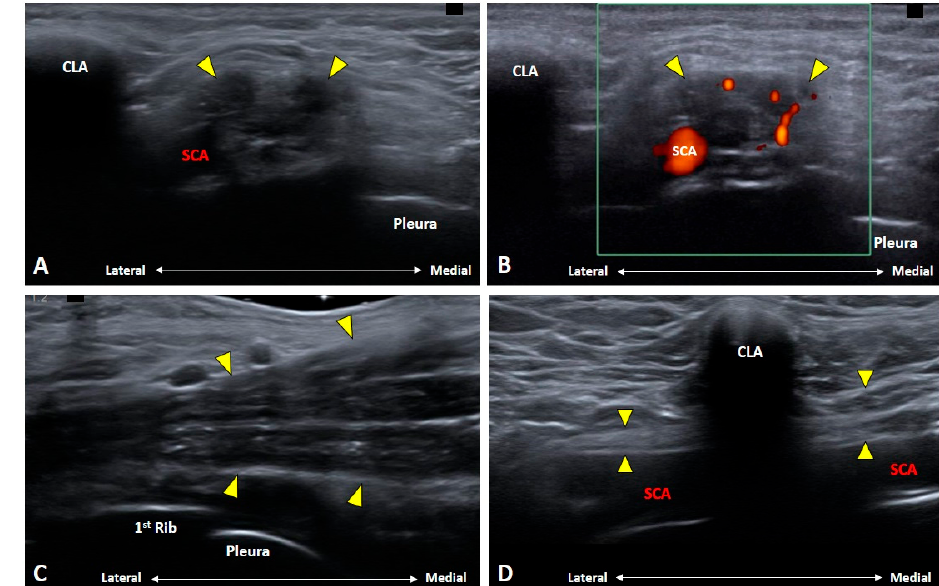
Figure 12. Ultrasound imaging of metastatic brachial plexopathy. The nerves (yellow arrowheads) are enlarged ( A ) with intra-neural hypervascularity ( B ). In the long-axis view, segmental swelling of the nerves (yellow arrowheads) are seen at the supraclavicular ( C ) and infraclavicular ( D ) levels. CLA: clavicle; SCA: subclavian artery.